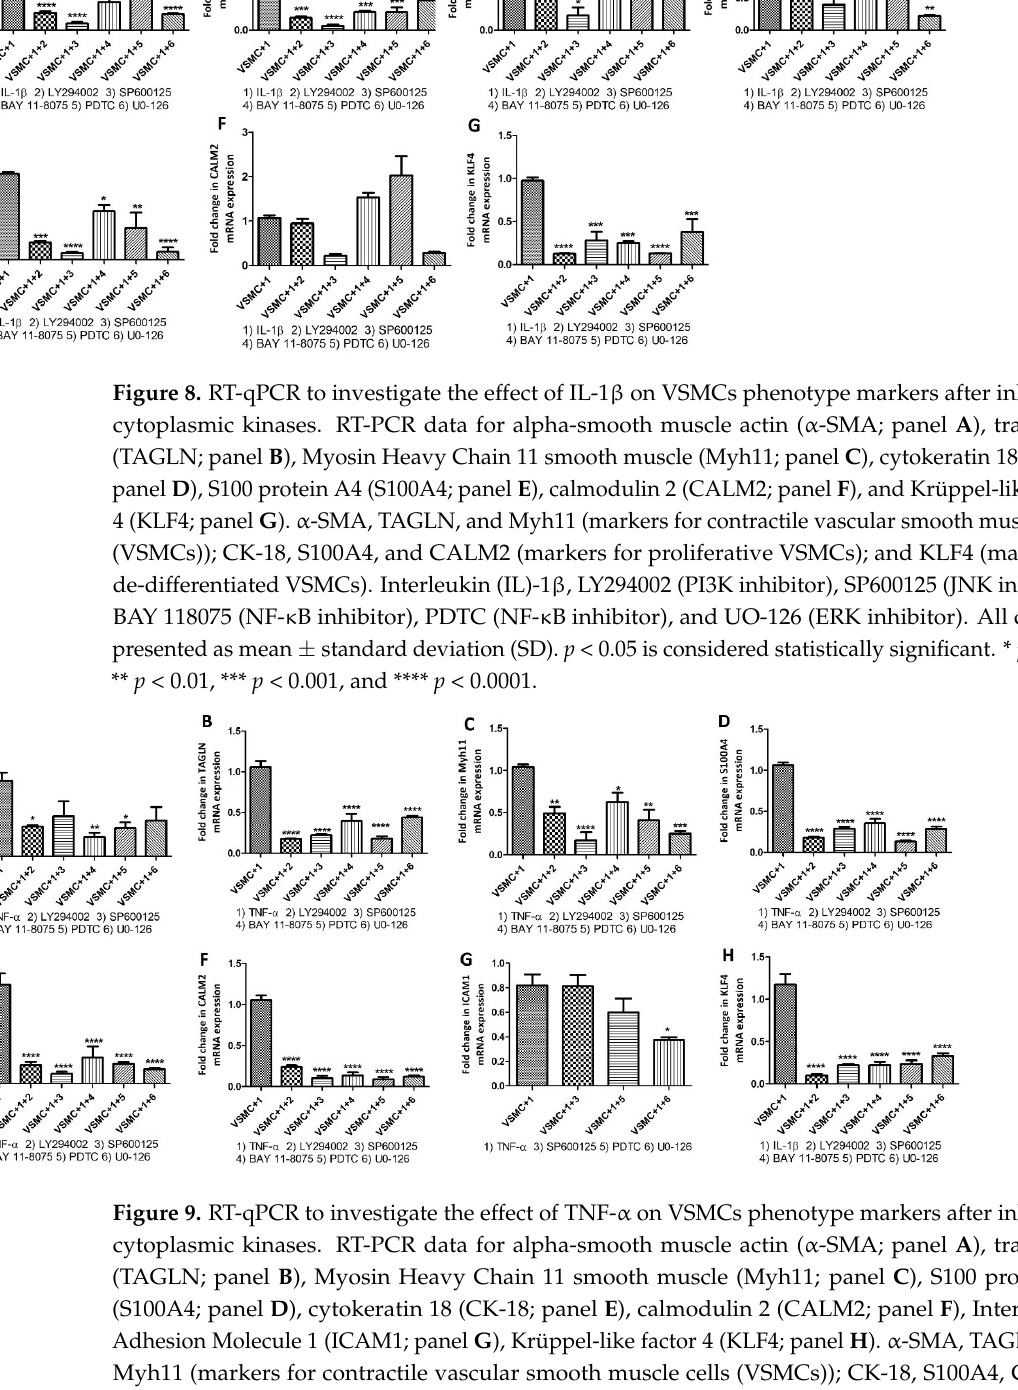
KLF4 (marker for de ‐ differentiated VSMCs). Interleukin (IL) ‐ 6, LY294002 (PI3K inhibitor), SP600125 (JNK inhibitor), BAY 118075 (NF ‐κ B inhibitor), PDTC (NF ‐κ B inhibitor), and UO ‐ 126 (ERK inhibi ‐ tor). All data are presented as mean ± standard deviation (SD). p < 0.05 is considered statistically significant. * p < 0.05, ** p < 0.01, *** p < 0.001, and **** p < 0.0001.